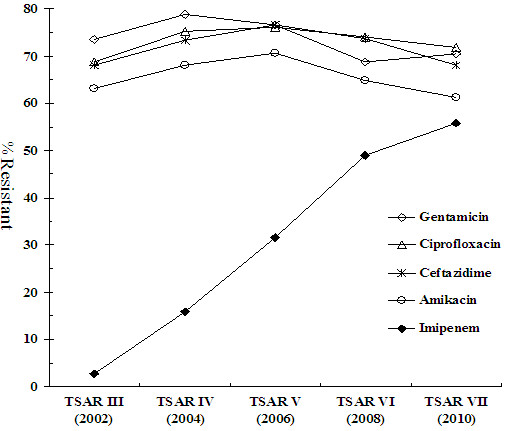
Rapid increase of imipenem-resistance in Acinetobacter baumannii complex (OR 2.277; 95% CI, 2.054-2.523;P < 0.001) in Taiwan based on the Taiwan Surveillance of Antimicrobial Resistance (TSAR) data. The secular trends of resistance to 4 other agents are shown for comparison.